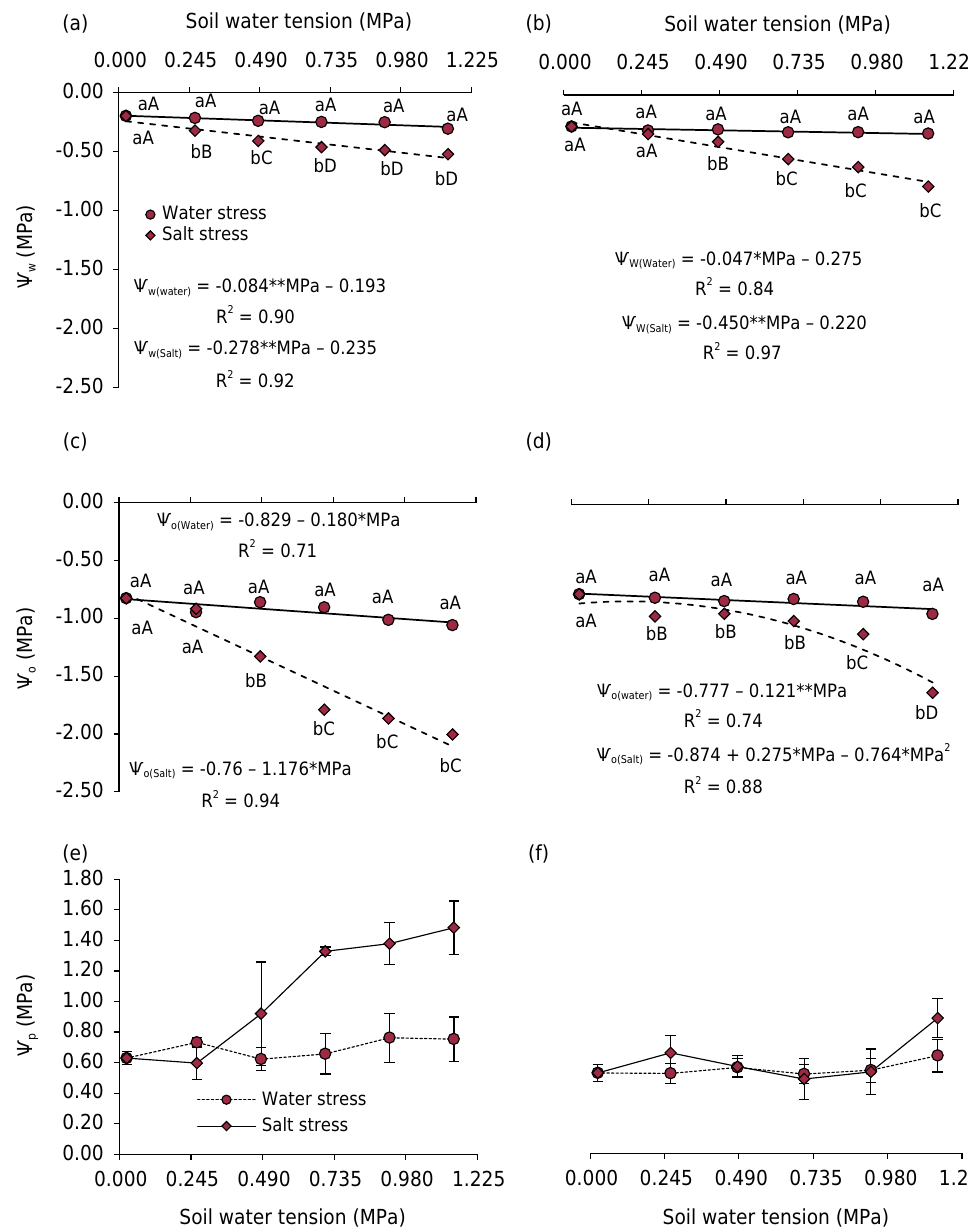
Figure 1. Leaf water potential (Ѱ W ) (a and b), osmotic potential (Ѱ O ) (c and d); turgor pressure potential (Ѱ P ) (e and f) of Vigna unguiculata plants (IPA-206 cultivar) evaluated seven days after stress by treatments applied at the vegetative and flowering stages, respectively. * Means followed by the same uppercase letter for the soil water tensions or same lowercase letter for stress sources were statistically similar by the Scott-Knott test at 5 %